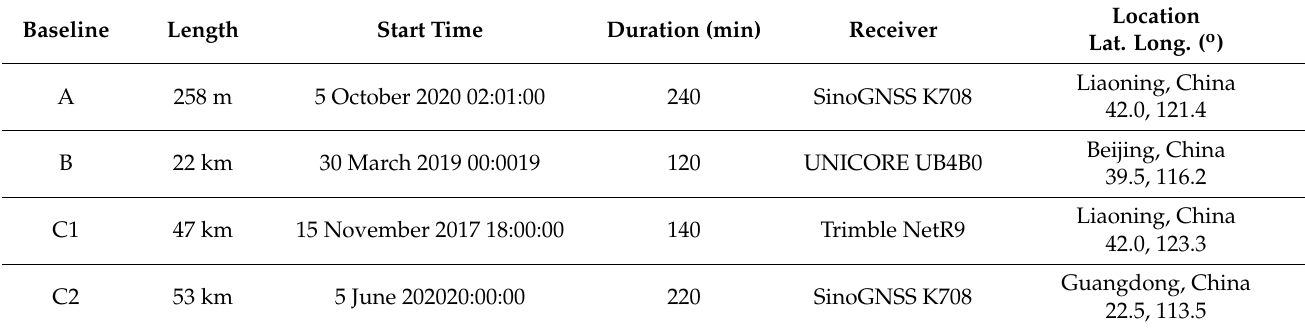
Table 1. Information of Baselines Employed in the